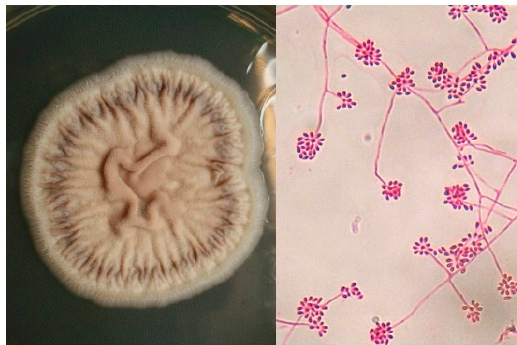
Figure 3. Culture of Sporothrix schenckii (Sabouraud media, 28 °C) Filamentous state with thin hyphae and denticle microconidia like “daisy flowers” (Erythrosine, 40×).